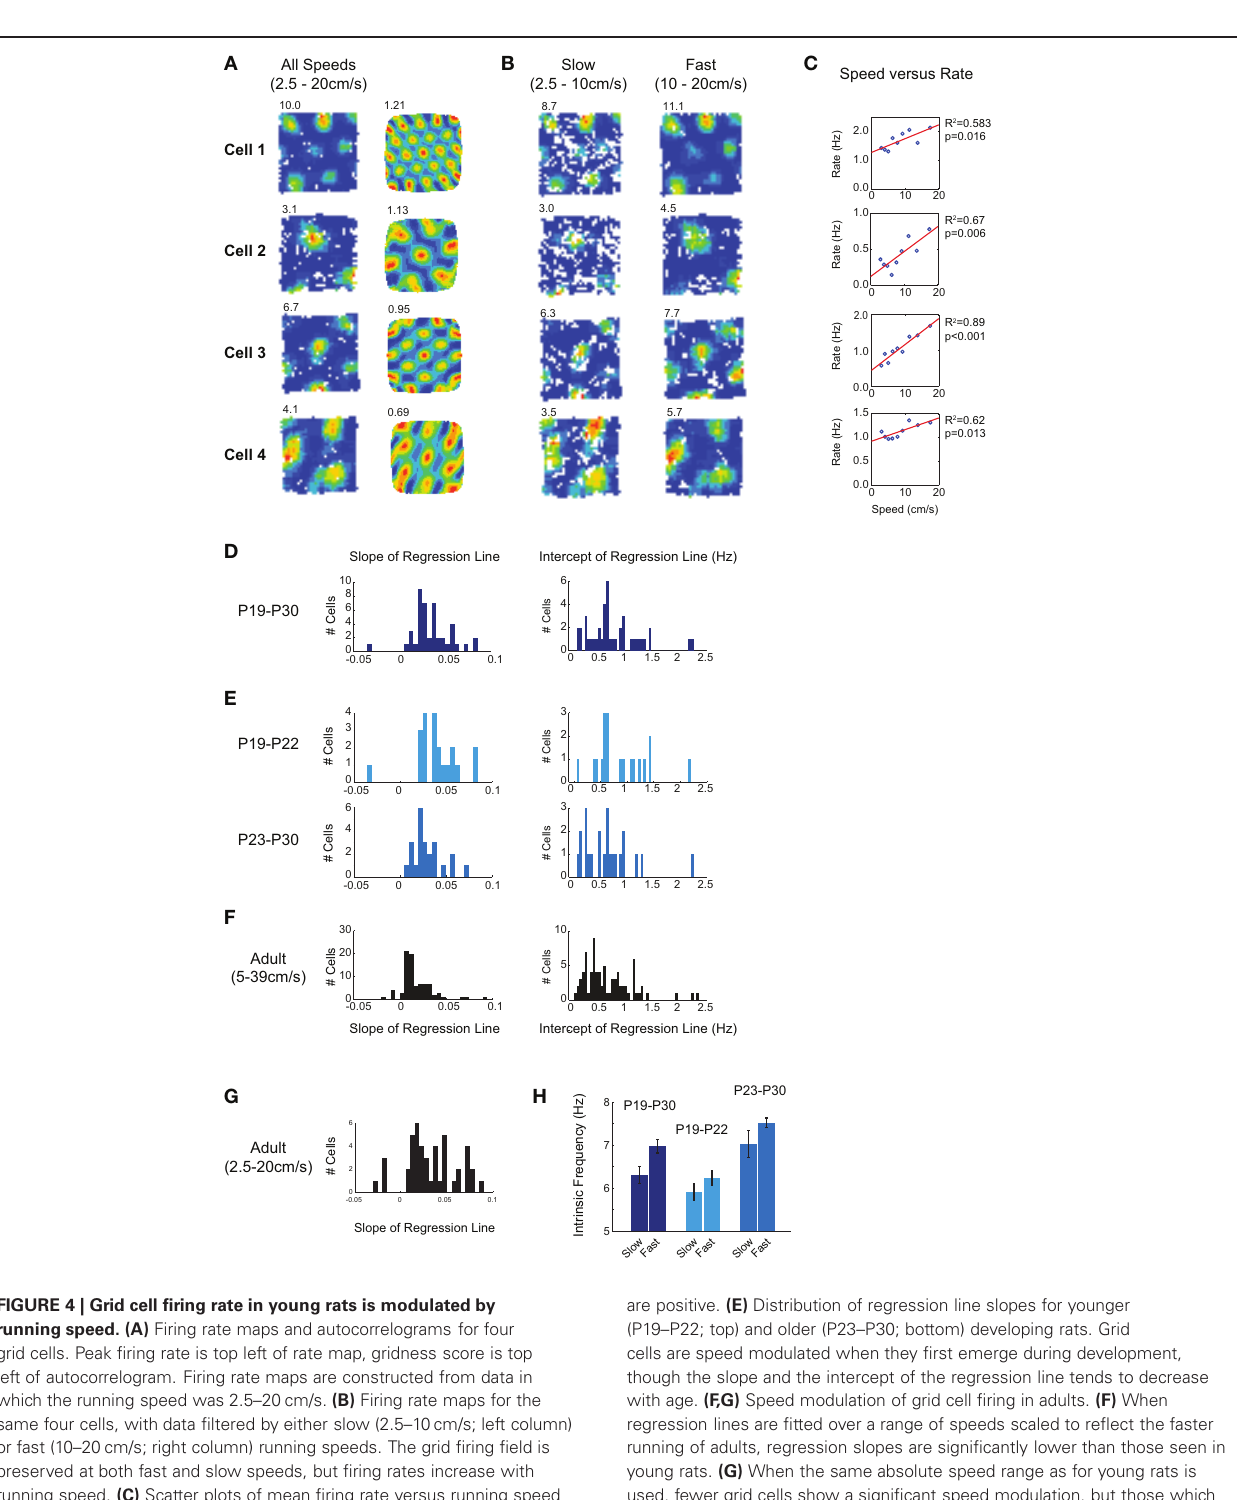
are positive. (E) Distribution of regression line slopes for younger (P19–P22; top) and older (P23–P30; bottom) developing rats. Grid cells are speed modulated when they first emerge during development, though the slope and the intercept of the regression line tends to decrease with age. (F,G) Speed modulation of grid cell firing in adults. (F) When regression lines are fitted over a range of speeds scaled to reflect the faster running of adults, regression slopes are significantly lower than those seen in young rats. (G) When the same absolute speed range as for young rats is used, fewer grid cells show a significant speed modulation, but those which do show similar slope values to those seen in young rats. (H) Intrinsic frequency of grid cell firing increases with running speed. Bars show mean intrinsic frequency of theta-modulated grid cells, ± SEM. “Slow” bars show data where speed lies between 2.5 and 8cm/s, “Fast” bars from 8 and 20cm/s. Dark blue shows all young rats, light blue P19–P22, and gray